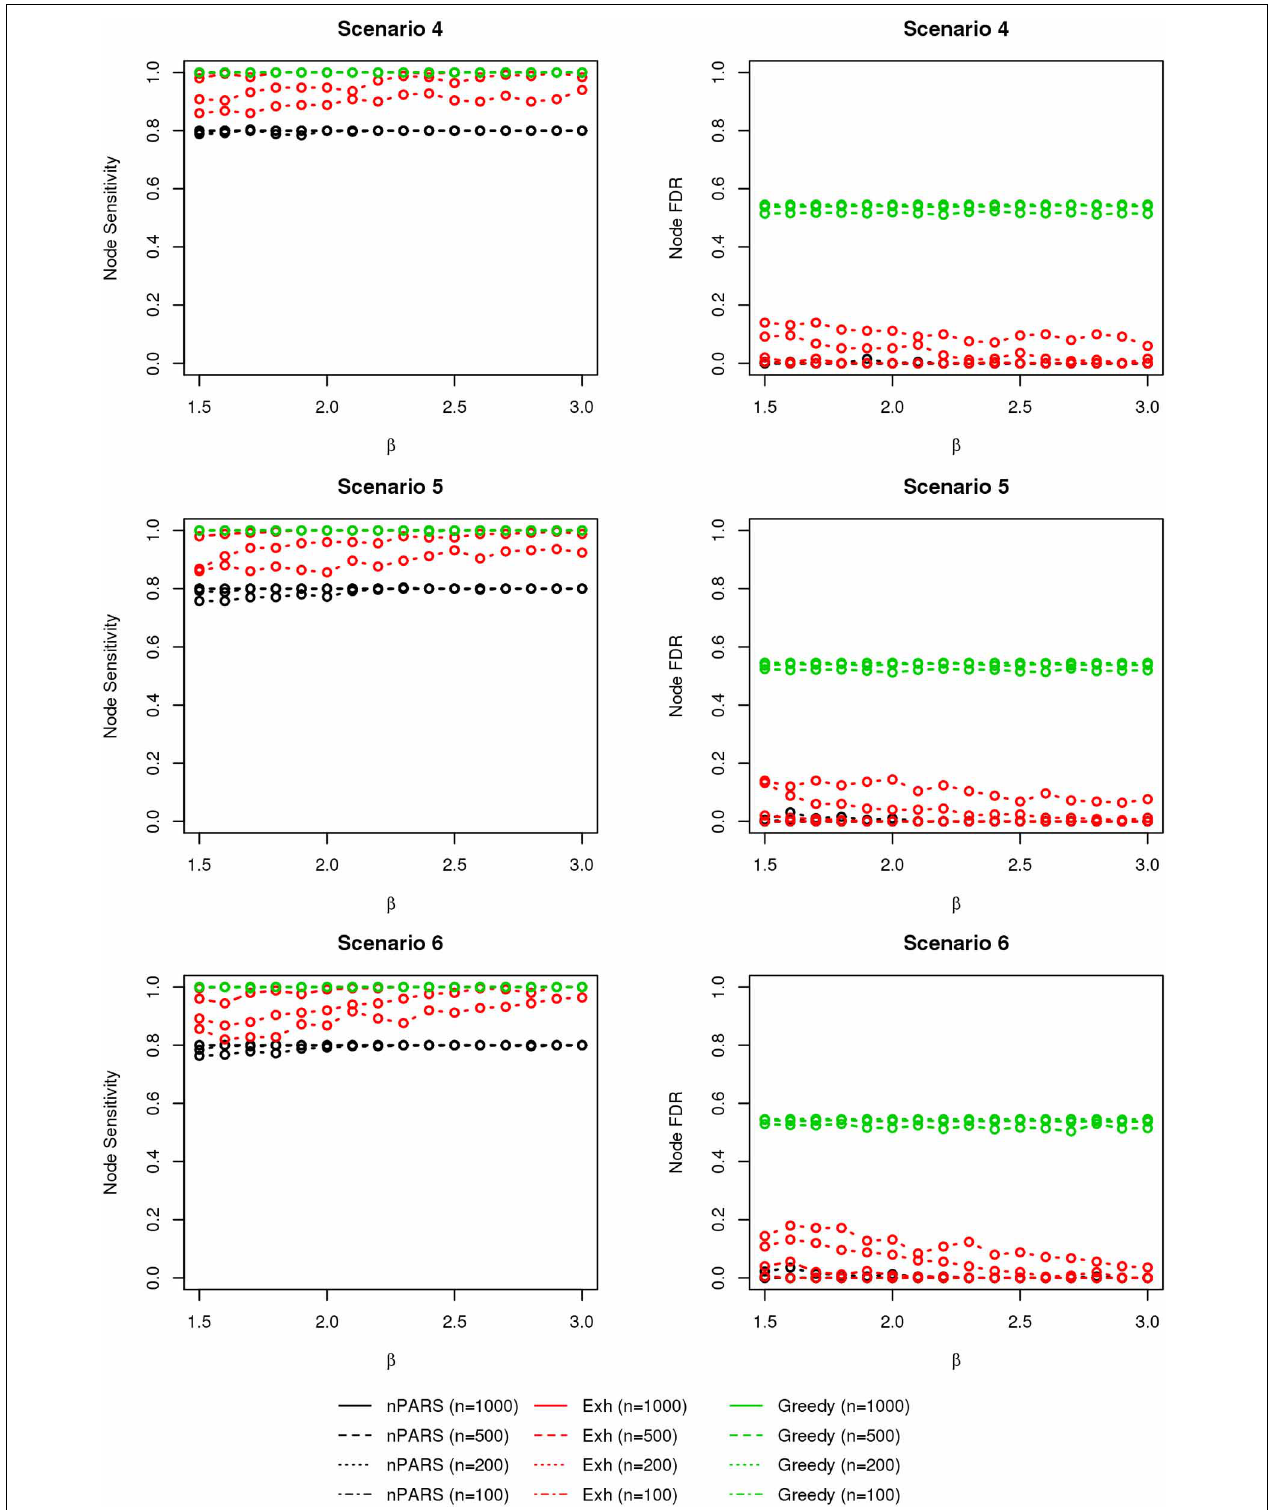
FIGURE 5 | ThesensitivityandFDRofnodecomparisonsinsimulationscenario4–6. Thesamelegendisusedasin Figure 3 .nPARSshowslowestnodeFDR withslightlylowernodesensitivitycomparetoexhaustivesearch.AlthoughgreedysearchexhibitshighestnodesensitivitybutitreportsrelativelyhighnodeFDR.